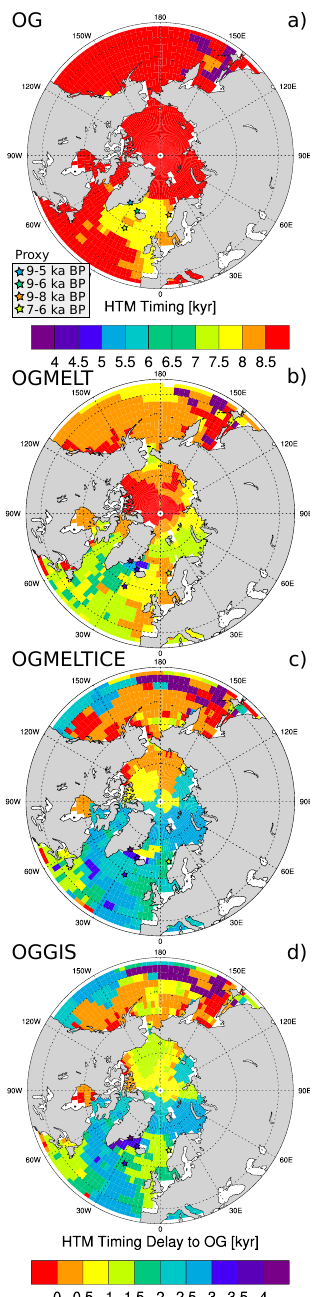
Fig. 7. Timing of the Holocene thermal maximum (inyrBP) based on simulated August SSTs in the Northern Hemisphere. The tim- ing is taken to be the maximum of a 1000yr running-mean- filtered August SST time series. Proxy core locations are indicated by stars: BS-88-06-5A (near Greenland); MD99-2269 (North Ice- land); MD95-2011 (near Norway); MD95-2015 (Gardar Drift). The colours of the stars represent the minimum of the HTM timing (a) and the maximum of the HTM delay (b, c, d) . Estimates of HTM timing are shown in the top figure. (a) shows simulation OG in ab- solute timing, (b) shows simulation OGMELT as delays compared to OG, (c) shows simulation OGMELTICE as delays compared to OG and (d) shows simulation OGGIS as delays compared to